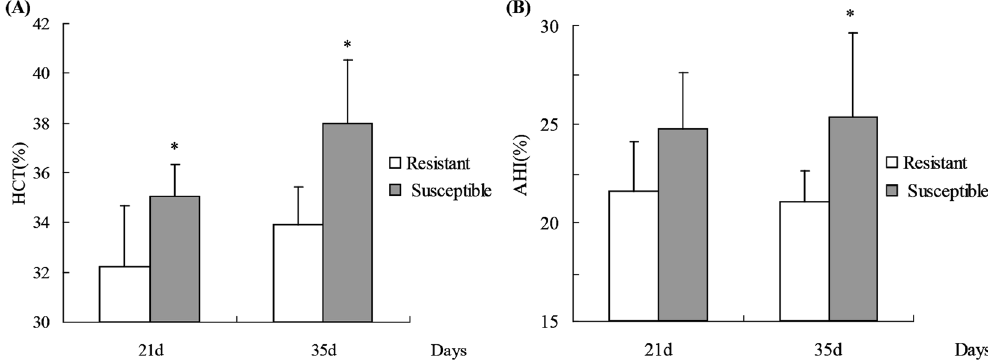
Figure 1. Haematocrit (HCT) and ascites heart index (AHI) of resistant and susceptible groups. ( A ) HCT and ( B ) AHI. Data are mean ± standard deviation (SD). * P <